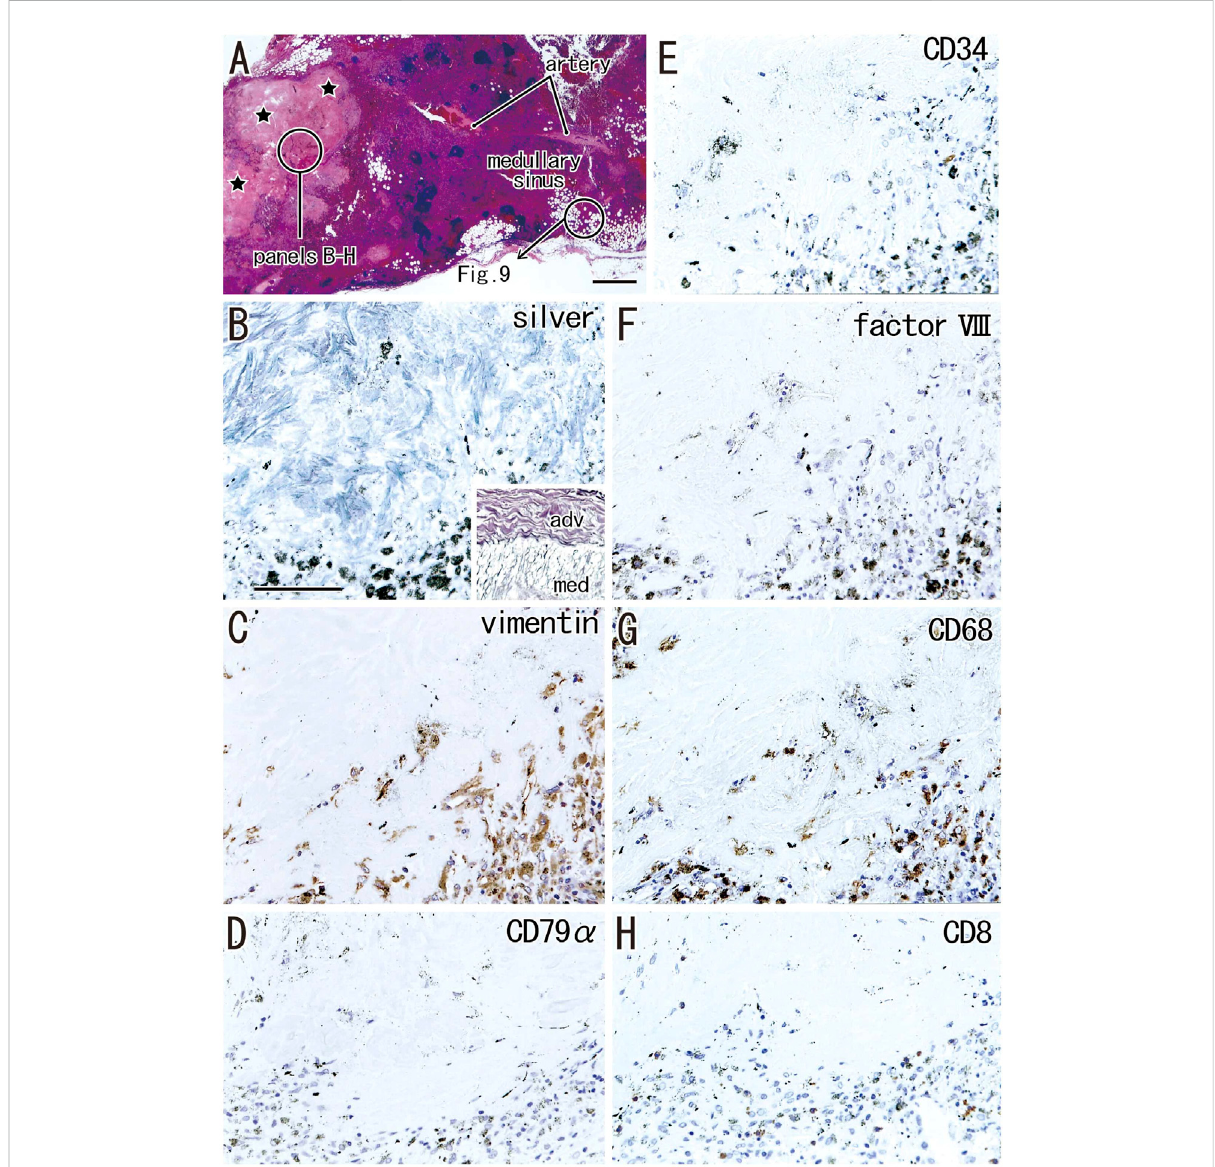
FIGURE 8 Immunohistochemistry of the cortical degeneration and the fatty degeneration. A hilar node removed from a 76-years-old man (non-smoker). This node contains a large degenerative area of the cortex [stars in (A) ] and the fatty tissue extending into the medullary sinus. (B – H) , sections near (A) , display a site indicated by a circle in (A) . The former contains blue-gray colored thick fi bers [silver staining; (B) ] those are negative for elastin and smoothmuscleactin(SMA;notshown).Aninsertatthelowerangleof (B) exhibitssilverstainingofawallofthearteryoutsideofthenode:typeI collagen fi bersoftheadventitia(adv)stainred-brown,whilebasallaminaeinthemedia(med)blue-gray.Thedegenerativeareacontainsvimentin-or CD68-positive cells (C,G) . Anthracotic macrophages are black-colored. No cells in the area are positive for CD79a and CD8. CD34 − or factor VIII- positive vessels are absent in the cortical degeneration. The DAB reaction made the positive cells brown. (B – H) were prepared at the same magni fi cation [scale bars: 1 mm in (A) ; 0.1 mm in (B)